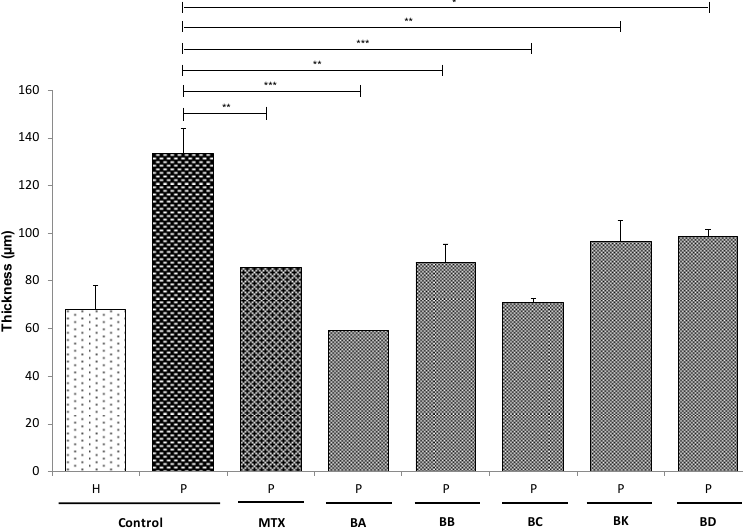
Figure 3. Epidermal thickness. Measurements of the living epidermis thickness of healthy (H) and psoriatic (P) skin substitutes without treatment (control) or treated with methotrexate (MTX), balsacone A (BA), balsacone B (BB), balsacone C (BC), (±)-balsacone K (BK), or (±)-iryantherin-D (BD). Statistical significance was determined using a one-way ANOVA ( p < 0.05). Data presented are means ± SD; N = 2, n = 2, 20 measurements per condition for each condition, except balsacone A, where N = 1, n = 2. (*** p < 0.001, ** p < 0.01, * p < 0.05).